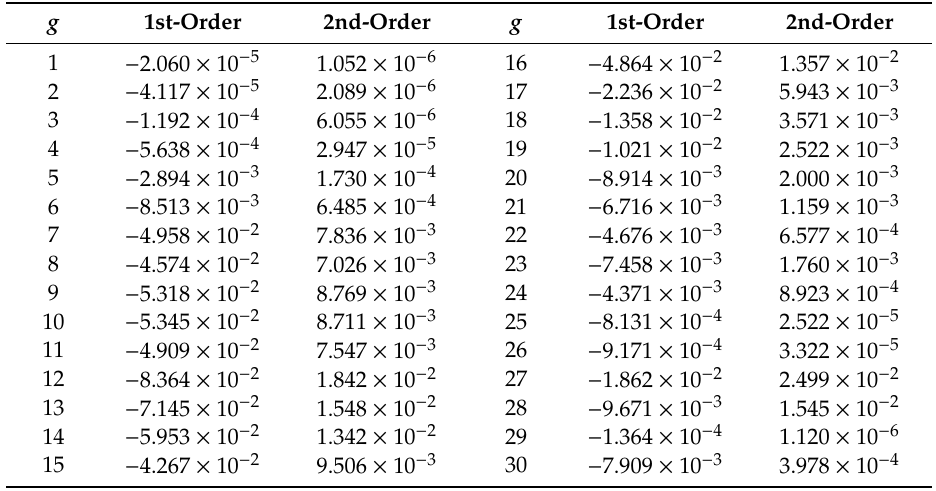
Table 6. Comparison of 1st-order relative sensitivities